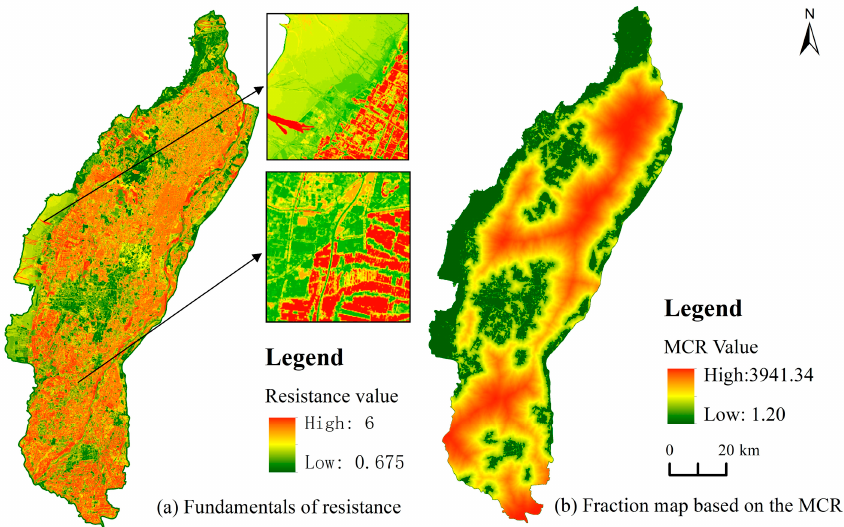
Figure 5. Resistance surface: ( a ) The fundamentals of resistance. Local details are enlarged for clear display. ( b ) The fraction map based on the MCR. Green represents a low resistance value, which facilitates the flow of the heat source; red represents a high resistance value, which hinders the flow of the heat source.